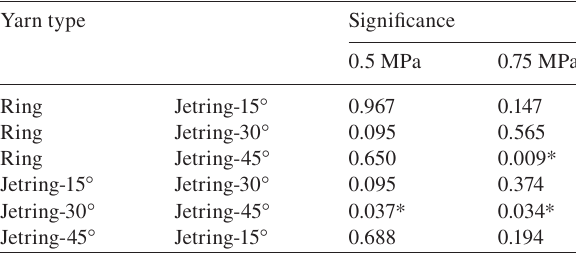
Table 4 ANOVA test results of twist